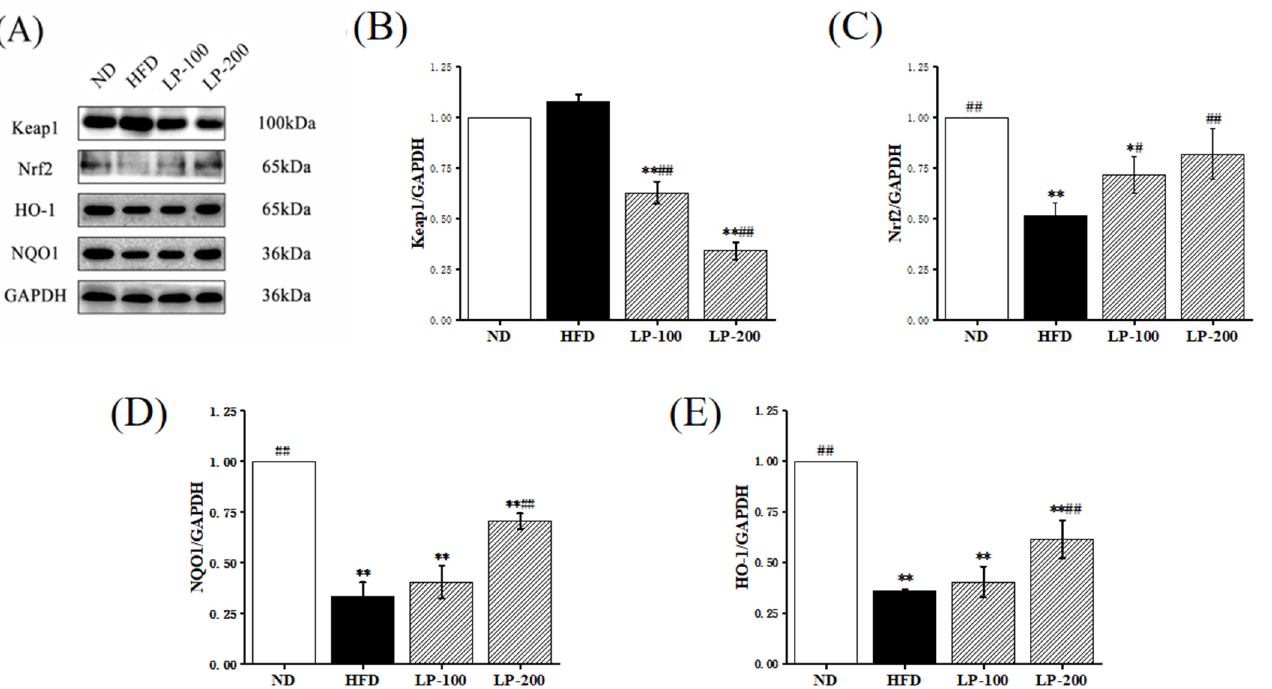
Figure 2. Effect of LPs on the antioxidant response mediated by Nrf2 in HFD-fed mice ( A – E ). Western blot showed the protein expression levels of Keap1, Nrf2, HO-1, and NQO1 in the renal lysates of mice fed with CD, CD+HFD, and CD+HFD+LPs. The signal intensity was quantitatively analyzed.